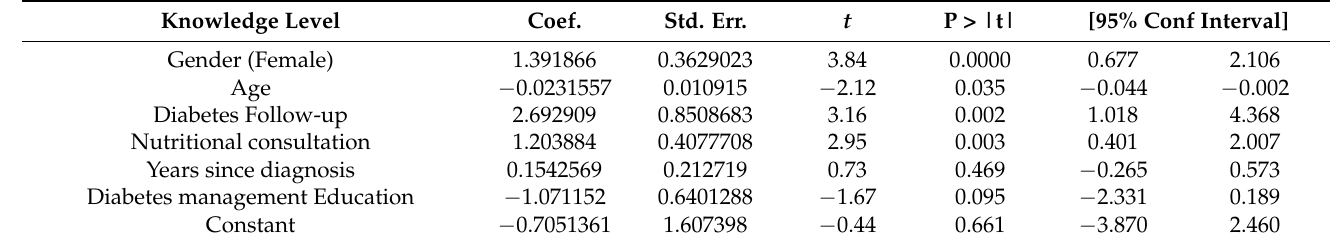
Table 7. Multiple regression analysis by level of food knowledge and independent variables.